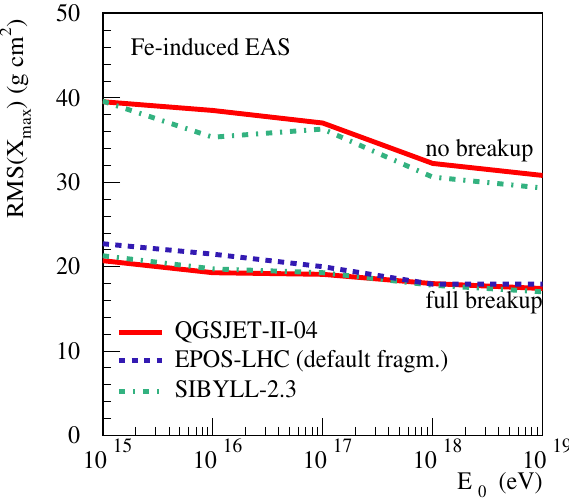
Figure 9. Primary energy dependence of RMS( X max ) for Fe-induced vertical EAS, calculated with QGSJET-II-04 and SIBYLL-2.3 (solid and dashed-dotted lines respectively) for two nuclear breakup options, as discussed in the text, compared to the default EPOS-LHC results (dashed